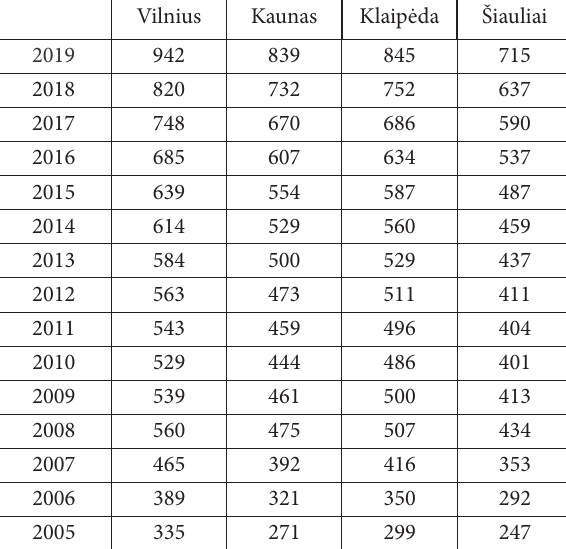
Table A3. Monthly net wage in Lithuanian cities in 2005−2019 (EUR) Vilnius Kaunas Klaipėda Šiauliai